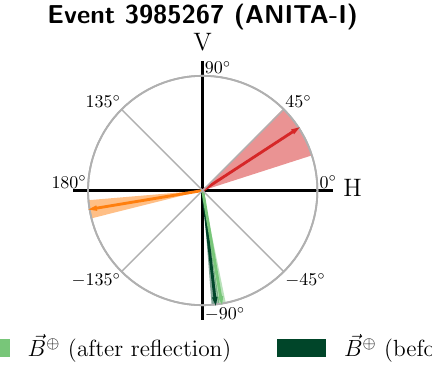
Fig. 2 Observed (orange) and incident (red) polarization angles. We also show the projection of the Earth magnetic field [22,23], in the reflected (light green) and incident (dark green) polarization planes.